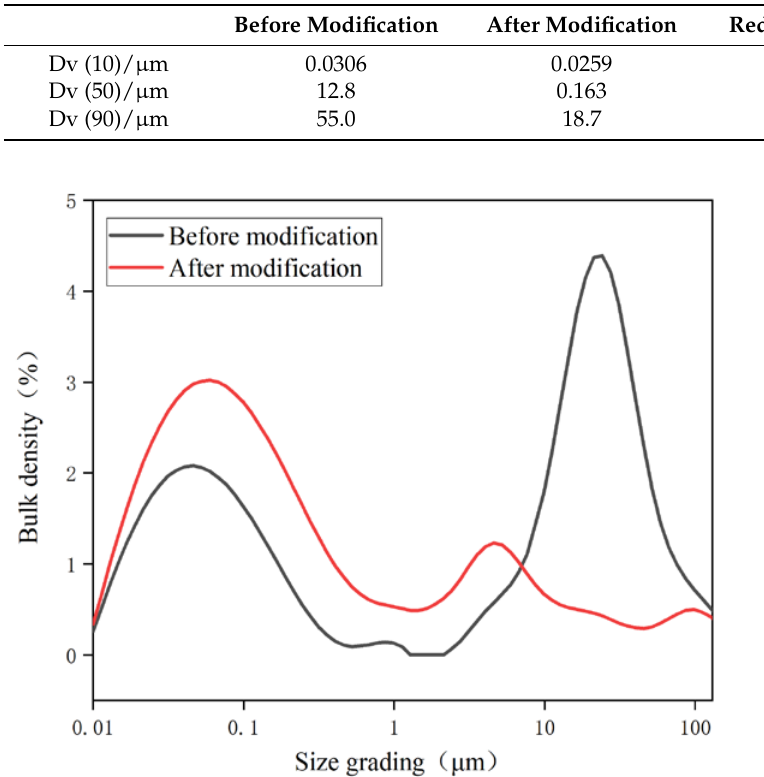
Table 2. Changes in particle size and volume of spent FCC catalyst before and after modification.